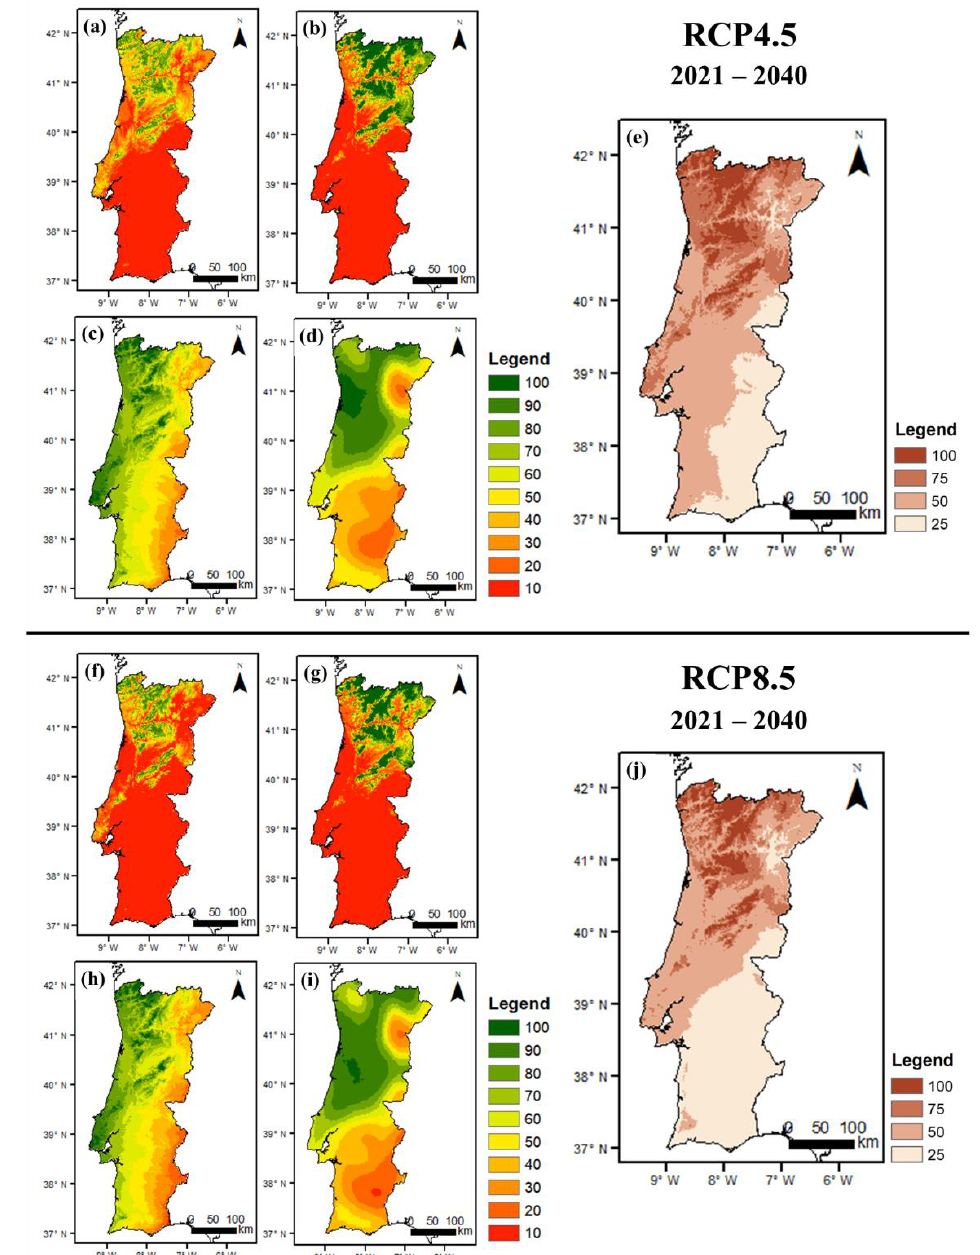
Figure 4. Mean percentage of occurrence of ( a , f ) growing degrees days between 1900 and 2400 ◦ C, ( b , g ) annual mean temperature between 8 and 15 ◦ C, ( c , h ) summer days with maximum temperature below 32 ◦ C, ( d , i ) annual accumulated precipitation between 600 and 1600 mm, and ( e , j ) chestnut suitability index, for 2021–2040, four GCM-RCM experiment, under RCP4.5 (top panel) and RCP8.5 (bottom panel).